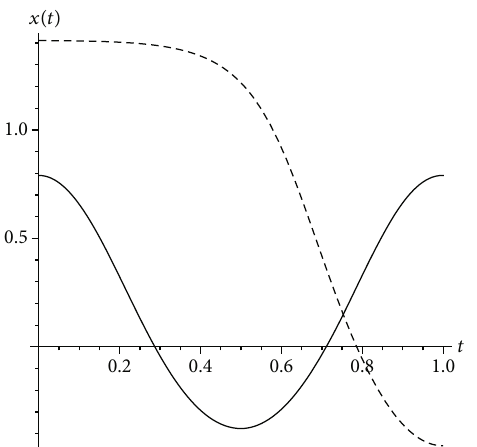
Figure 13: Graphs x ð t Þ for solutions of problems (15) and (37), x α ≈ 0 : 79 , x α ≈ 1 : 4115 (dashed).